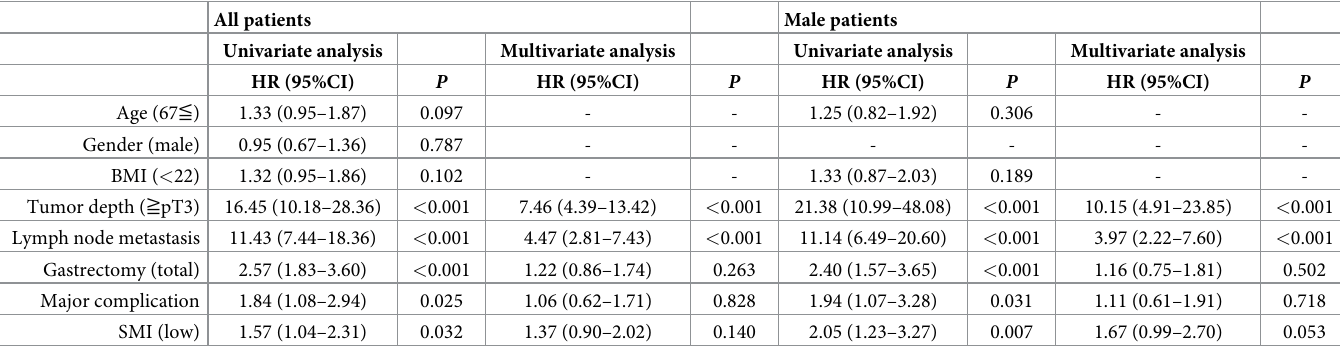
Table 3. Univariate and multivariate analysis of cancer-specific